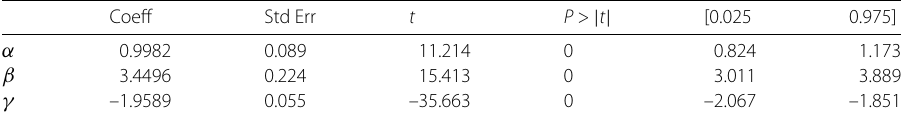
Table 2 Huff Model Parameters resulting from optimization via OLS method Coeff Std Err t P > | t | [0.025 0.975] α